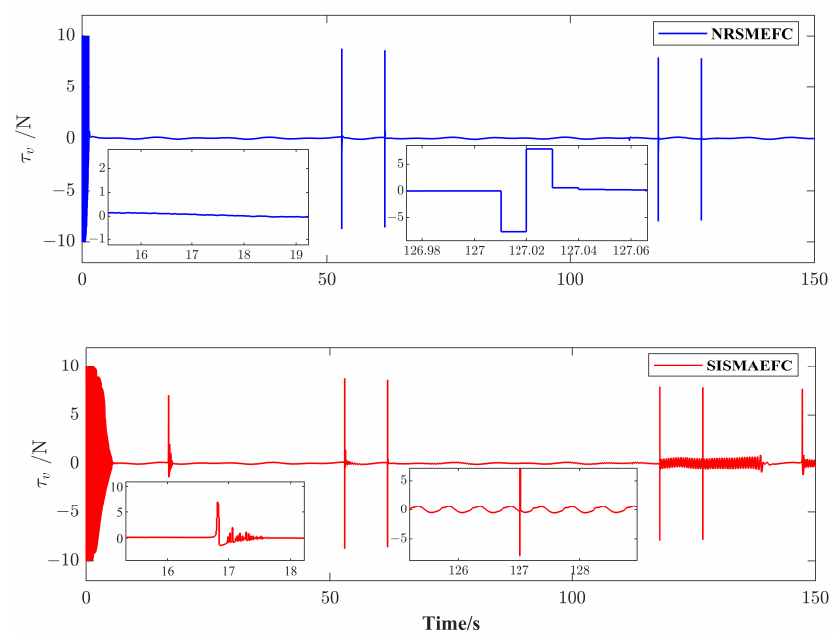
Figure 9. Differential coupling input τ v comparison.